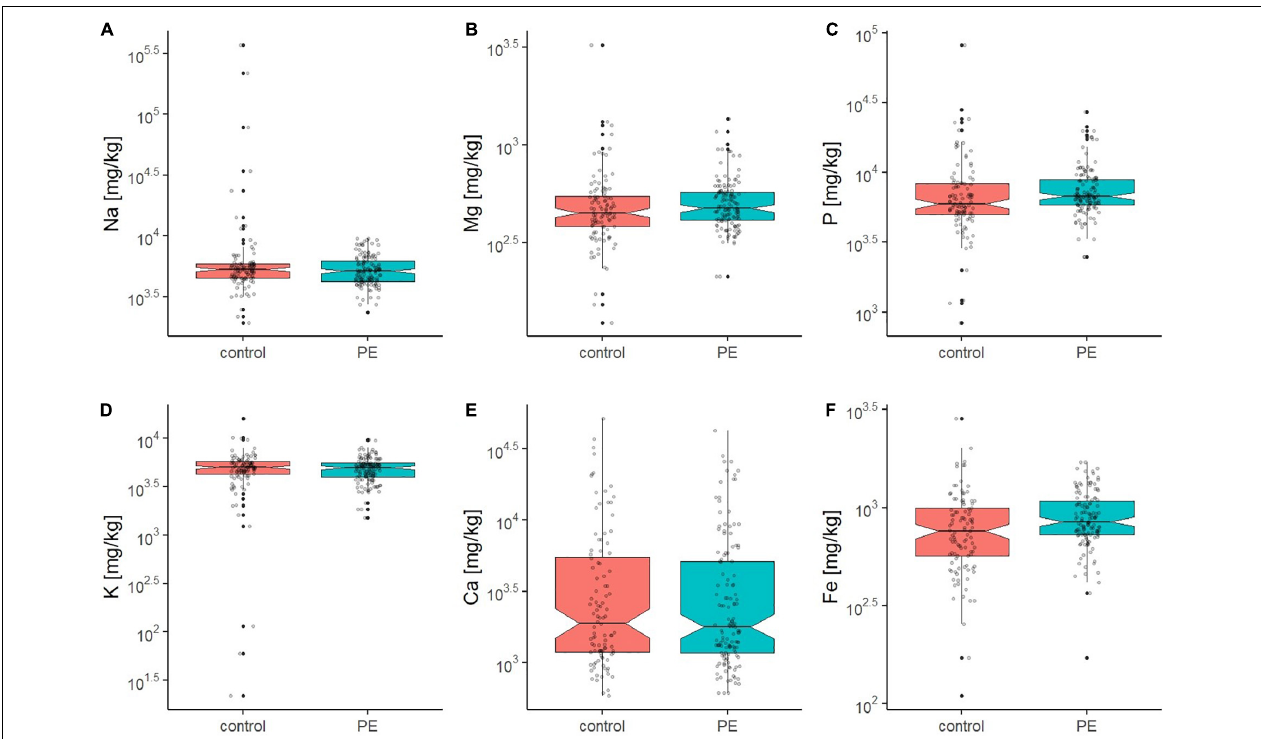
FIGURE 1 | Boxplots (A–F) showing the concentration of Na, Mg, P, K, Ca, and Fe in the placental tissue of the control (red) and PE (green) placenta group as determined by ICP-OES. Outliers are displayed as filled black dots. The entire distribution of data points is shown as gray transparent dots. The black line displays the median and notches the 95% confidence interval of the median. For all displayed elements except Fe, control and PE group did not show significant differences in the mean ( p > 0.05), also indicated by their overlapping